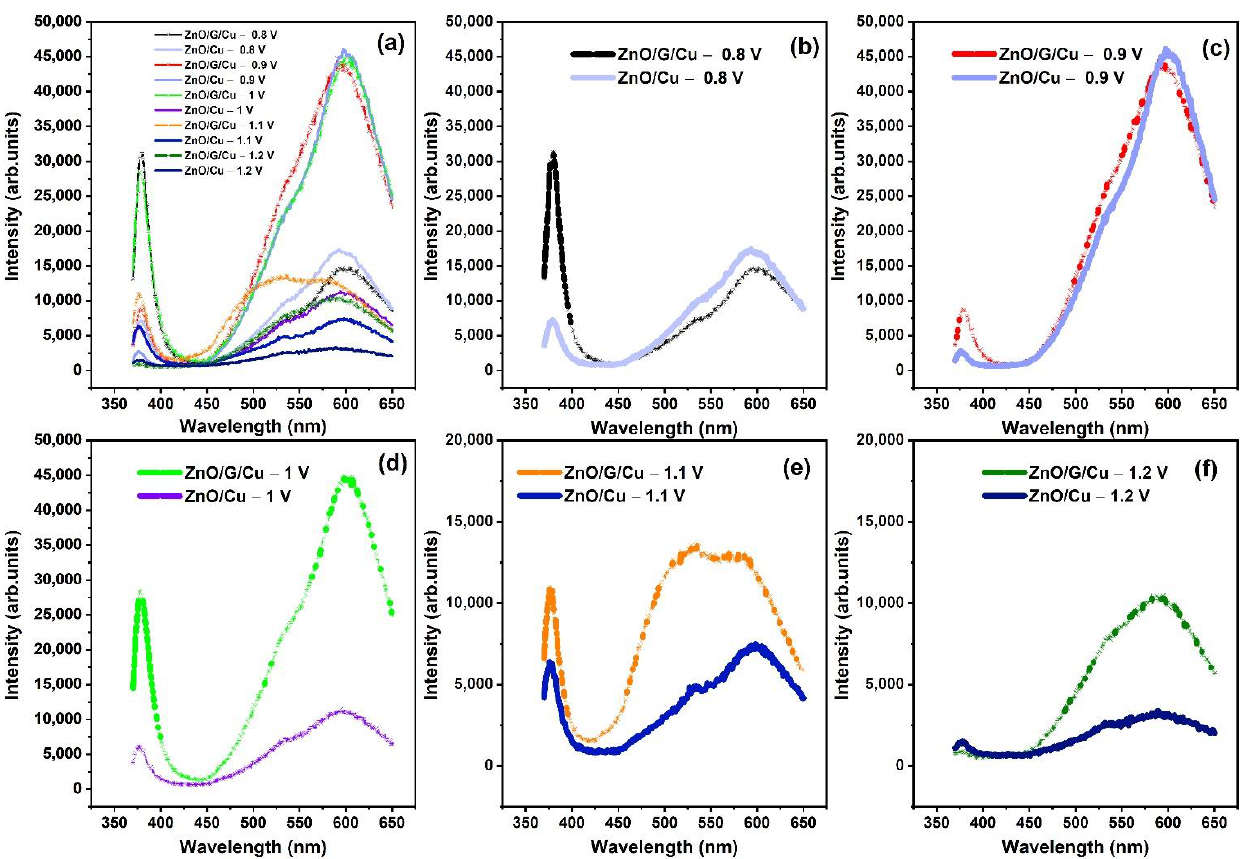
Figure 12. (a – f) PL spectra of ZnO/Cu and ZnO/G/Cu prepared at different applied potentials. Figure 12. ( a – f ) PL spectra of ZnO/Cu and ZnO/G/Cu prepared at different applied potentials. In Figure 13a,b, the Gaussian fitting for the PL spectra of ZnO NWs grown on Cu and ZnO NWs grown on graphene/Cu are presented. Black lines correspond to the experi- Table 3. Chromaticity coordinates and the PL intensities ratio of the UV emission to the visible mental data and color lines represent the fitted data. The broad visible emission bands emission for ZnO/Cu and ZnO/G/Cu films. were deconvoluted into three PL peaks. The green emission peak located around 531 – 535 CIE I uv /I vis nm is attributed to the ionized oxygen interstitial and/or complex of V O Zn i . The green- Samples Potential (V) x y yellow emission peak around 588 – 601 nm corresponding to the defects induced by oxy- gen vacancies (V O ) situated in the ZnO lattice is the luminescence produced by the recom- bination of photogenerated holes with electrons of the V O [59]. The yellow-orange emis- sion peak at 635 – 639 nm is usually attributed to the presence of O interstitials [60,61]. Due to the relative intensities of the three peaks, the center of the visible PL bands emission shows a blue shift for ZnO/G/Cu with respect to the ZnO/Cu, a possible cause for this behavior being the interaction between ZnO nanowires and the graphene.